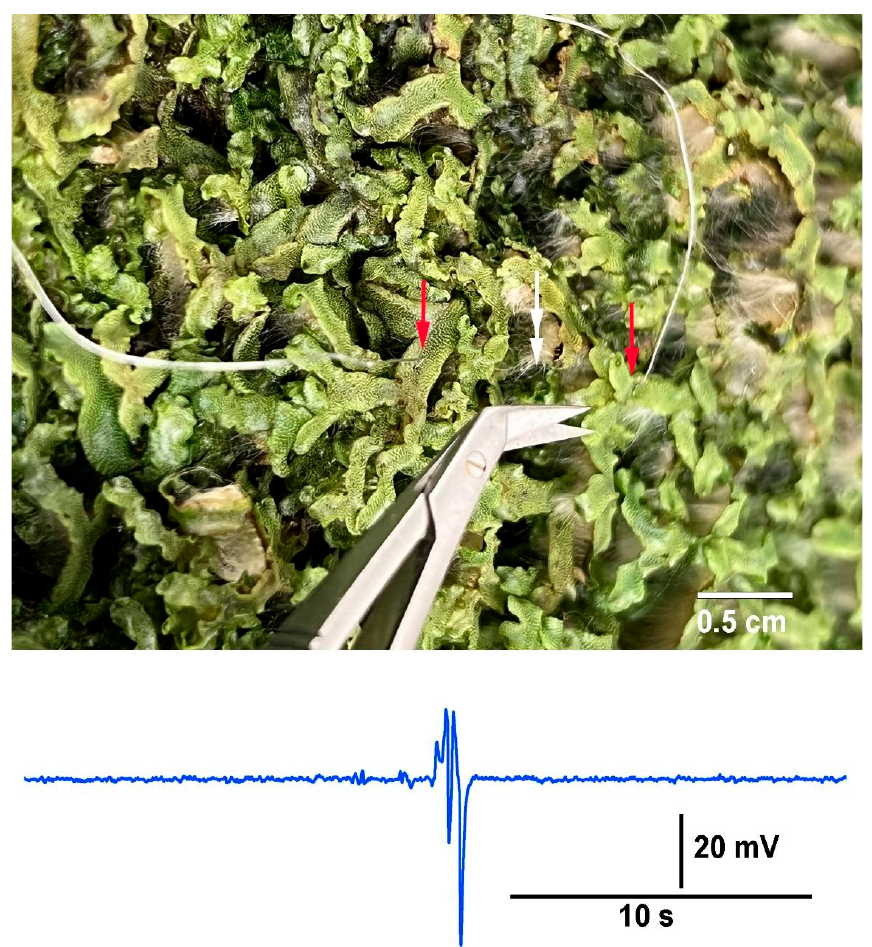
Figure 13. Electrical response to an injury of a neighboring plant in an aggregate of liverworts Marchantia inflexa . The electrical signal was detected by the impedance leads which were impaled into the thallus of two plants 5 cm apart from each other. The red single arrow heads indicate where the leads were placed, and the white double arrowhead indicates where the cut was made to one thallus halfway in between the two leads.